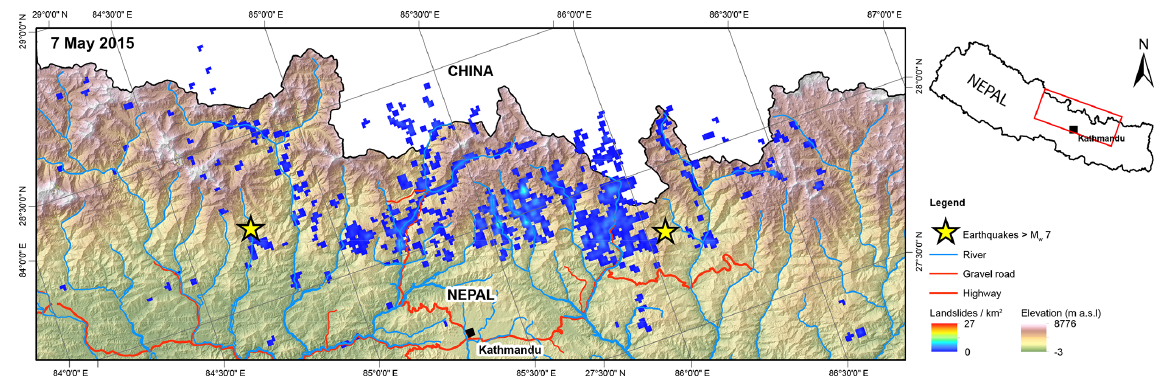
Figure 4. Extract from map released on 7 May 2015, 12 days after the Gorkha earthquake. Colored zone shows landslide distribution and relative intensity (number of landslideskm − 2 ). The color map has been adjusted to a range of 0–27landslideskm − 2 for comparison between Figs. 4 and 5. At this point, all areas in the map extent had been assessed using at least pan-sharpened Landsat 8 imagery (15m). VHR ( < 3m) optical imagery had been used where available.